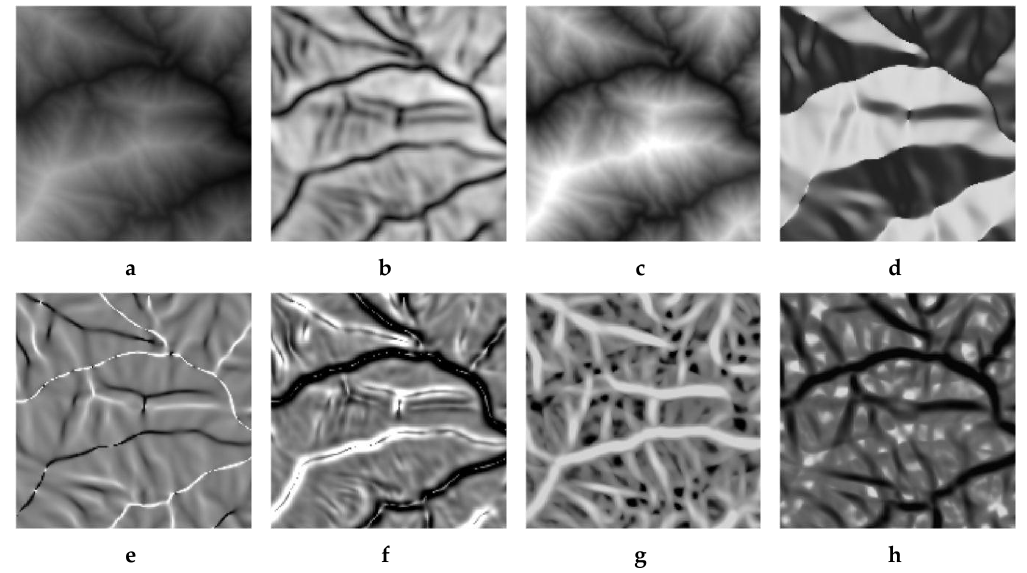
Figure 3. DTMs of a sample area ( a ) DEM; ( b ) Slope; ( c ) Topographic Position Index (TPI); ( d ) Aspect; ( e ) Plan curvature; ( f ) Profile curvature; ( g ) Maximum curvature; ( h ) Minimum curvature.